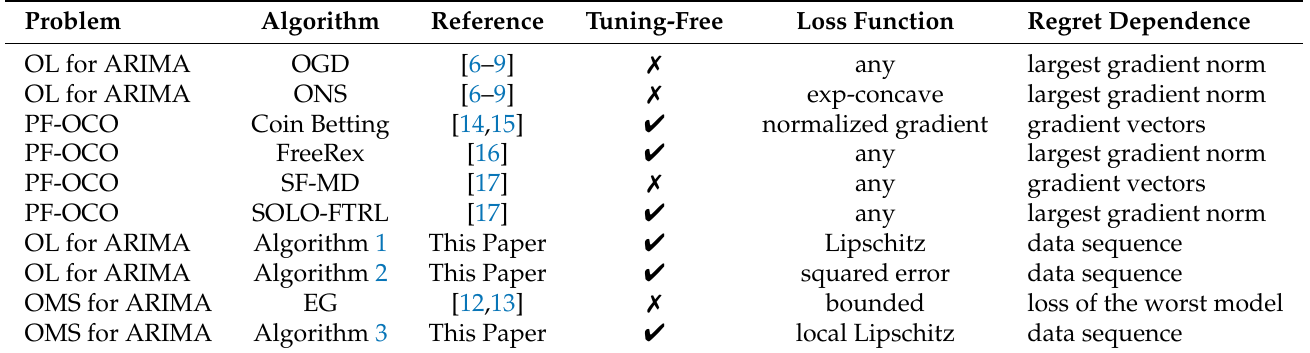
Table 1. Algorithms for online learning of